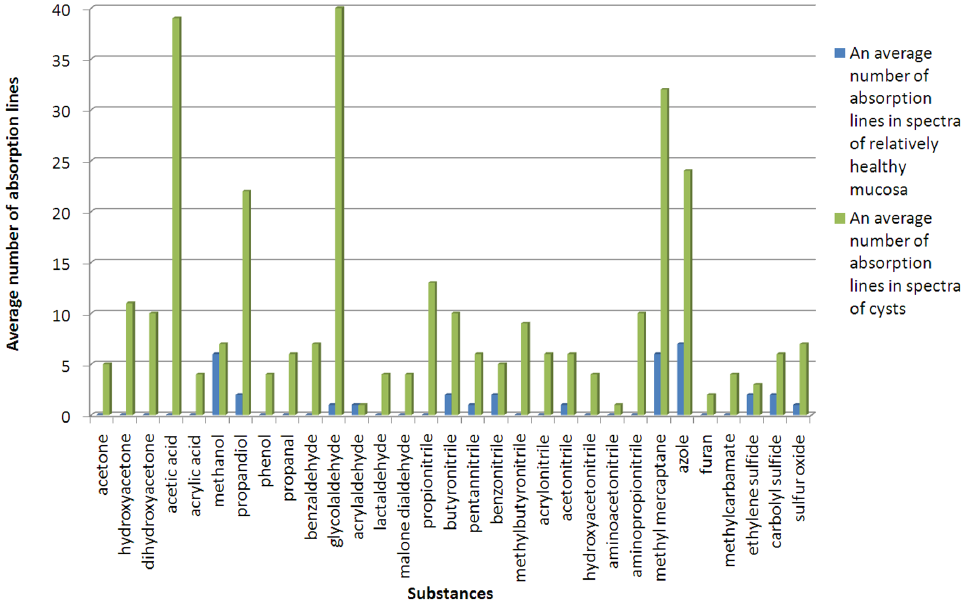
Figure 4. The chemical composition of the products of the thermal decomposition of cysts (green) and relatively healthy mucosa (blue) samples.